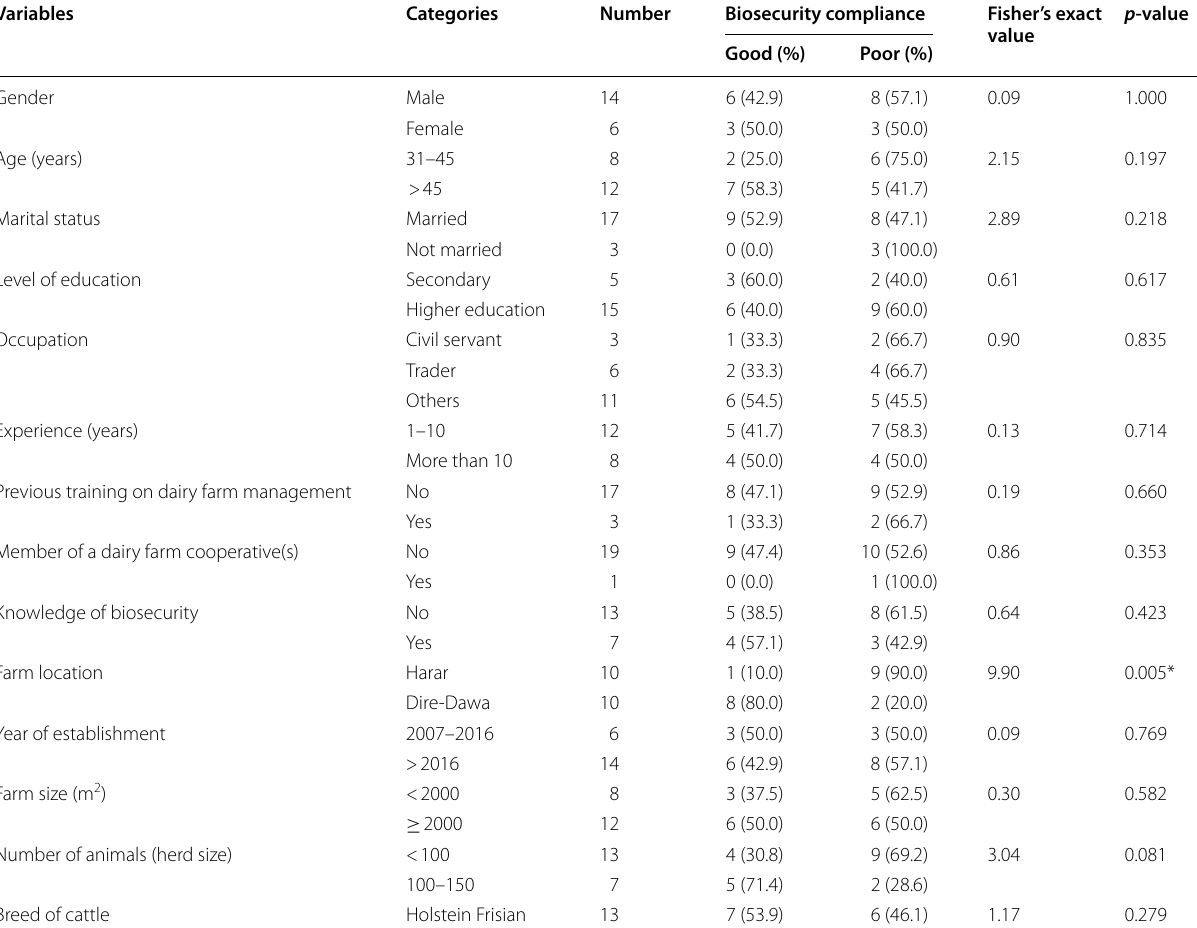
Table 10 Assessment of association between respondent’s socio-demographic and farm characteristics with general